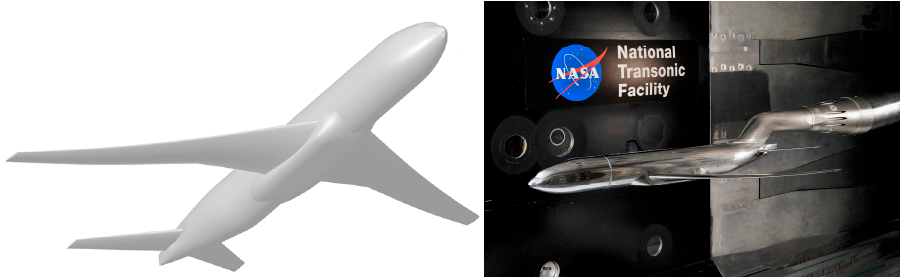
Figure 3. Common Research Model (CRM) aircraft in its original wing-body-tail (WBT) configuration (i.e., with horizontal tail only). CAD model ( left ) and small-scale experiment (( right ), reproduced from [47] with NASA courtesy).